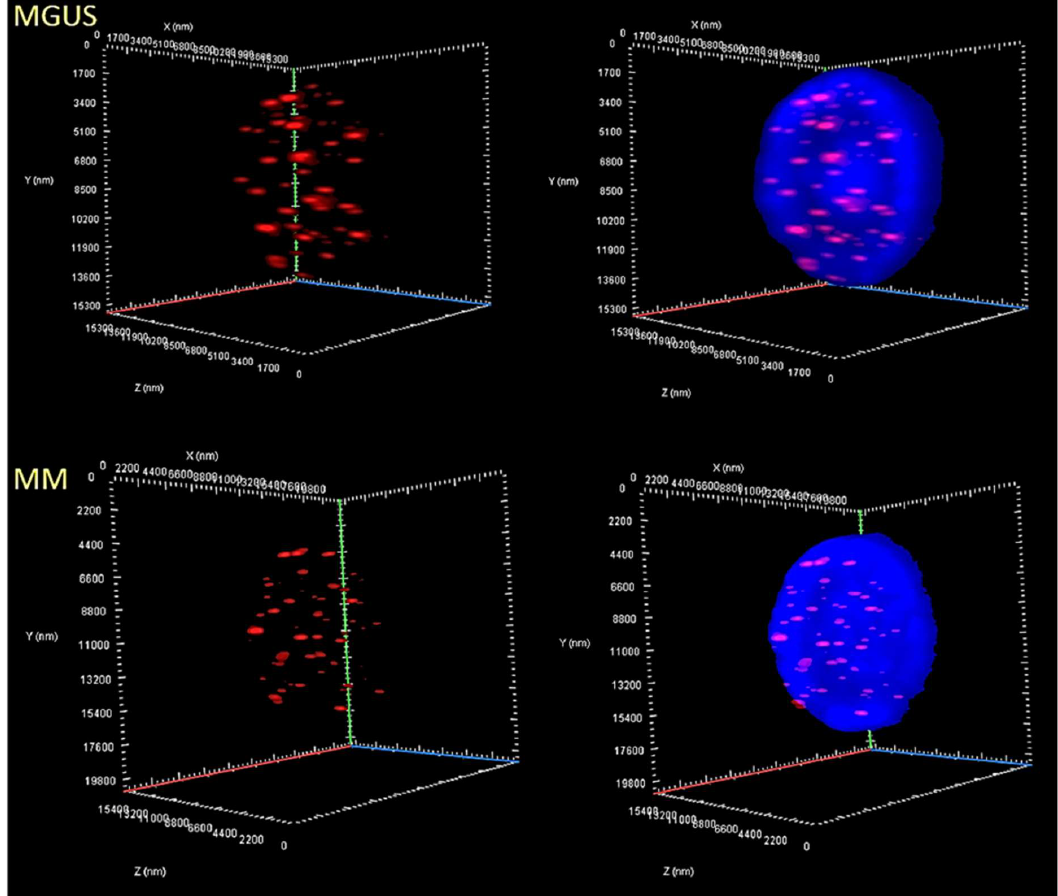
Figure 2. Differences in the 3D nuclear telomeric architecture between MGUS and MM. Representative nuclei, counterstained with DAPI (blue) from MGUS and MM patient samples, where Cy3 labeled telomeres appear as red dots. Numerous parameters were altered between the two disease stages. Most notably, in MM, compared to MGUS, there was a greater frequency of less-intense signals, correlating to a predominance of shorter telomeres, which by itself is indicative of telomere attrition and genomic instability.